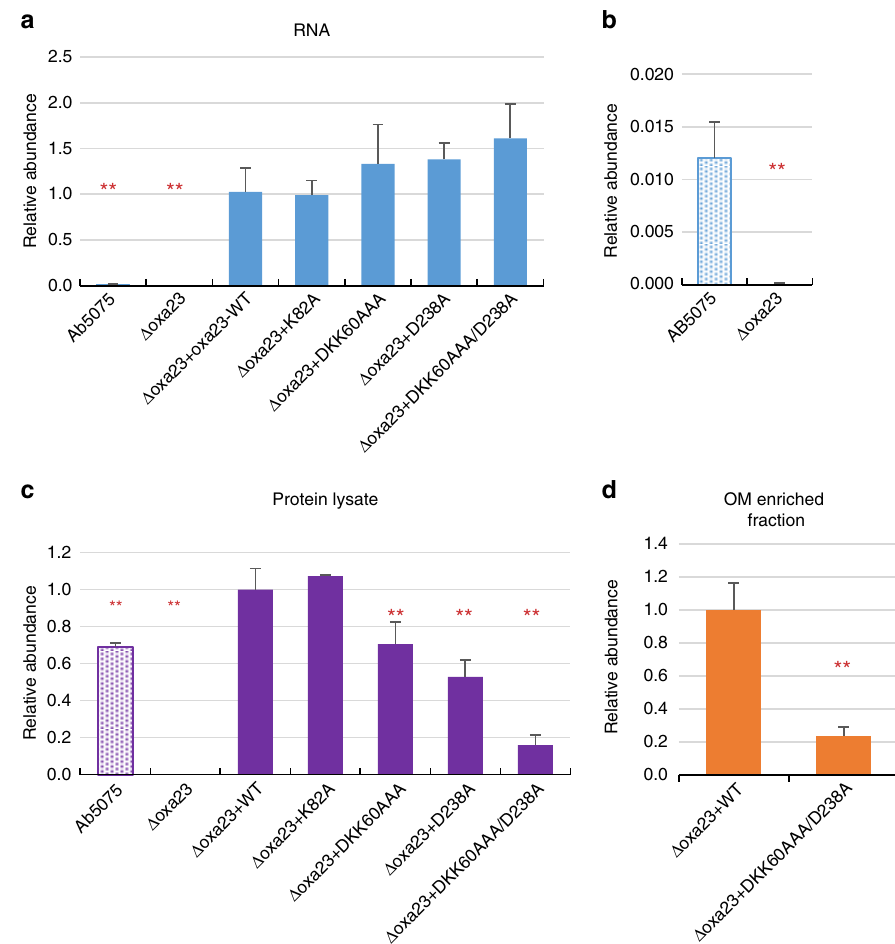
Figure 6 | RNA- and protein-level comparison of oxa-23 expression in D oxa23 complementation mutants. ( a ) Quantitative PCR measurements of oxa-23 RNA level in AB5075, D oxa23 deletion mutant and D oxa23 complementation mutants. O xa-23 RNA level was referenced to the 16S RNA . Similar results were also obtained with an independent oxa-23 primer set (Supplementary Fig. 11A). Error bars indicate the s.d. for the three biological replicates examined for each strain. **Statistical significance compared with D oxa23 complementation mutant with WT-oxa23 gene (** P o 0.01, one-way unpaired analysis of variance (ANOVA), n ¼ 3). ( b ) Zoom-in view of the relative oxa-23 RNA level for AB5075 and D oxa23 deletion mutant. ( c , d ) Comparison of Oxa-23 protein levels in whole cell lysate ( c ) or OM protein-enriched fraction ( d ) in AB5075, D oxa23 deletion mutant and D oxa23 complementation mutants examined with parallel reaction monitoring (PRM) assays. Error bars indicate the s.d. for the three biological replicates. One microgram of protein digest was loaded for each PRM analysis. **Statistical significance compared to D oxa23 complementation mutant with WT-oxa23 gene (** P o 0.01, one-way unpaired ANOVA, n ¼